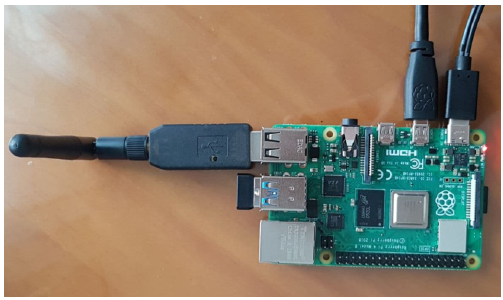
Figure 22. Raspberry pi 4 and zzh! providing gateway functionalities to integrate home sensors.